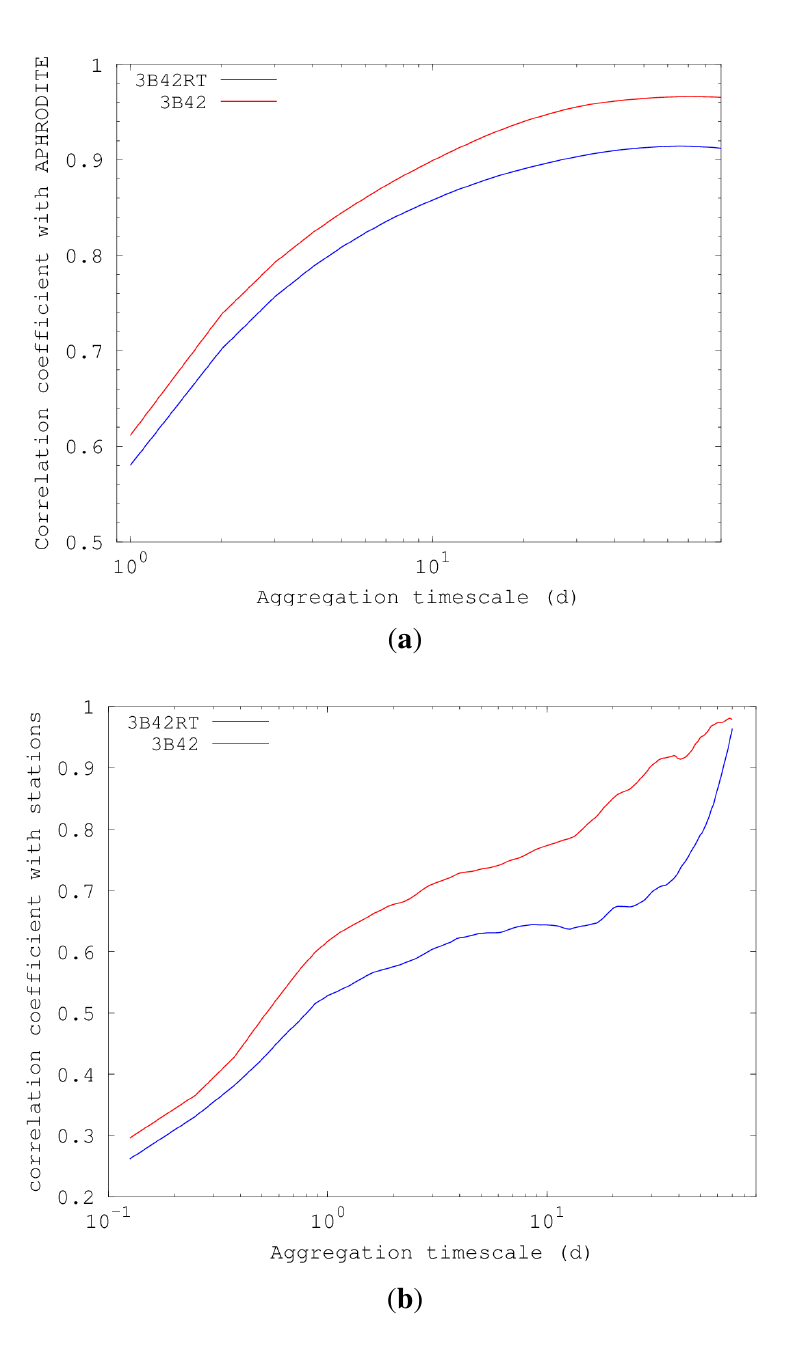
Figure 2. Rank correlation of precipitation of the satellite-based 3B42RT and 3B42 products as a function of aggregation timescales: ( a ) Correlation with the gauge-based APHRODITE product for 2001–2007 over aggregation timescales from 1 to 90 days; ( b ) Correlation with automated weather stations for 2013–2014 over aggregation timescales from 3 hours to 90